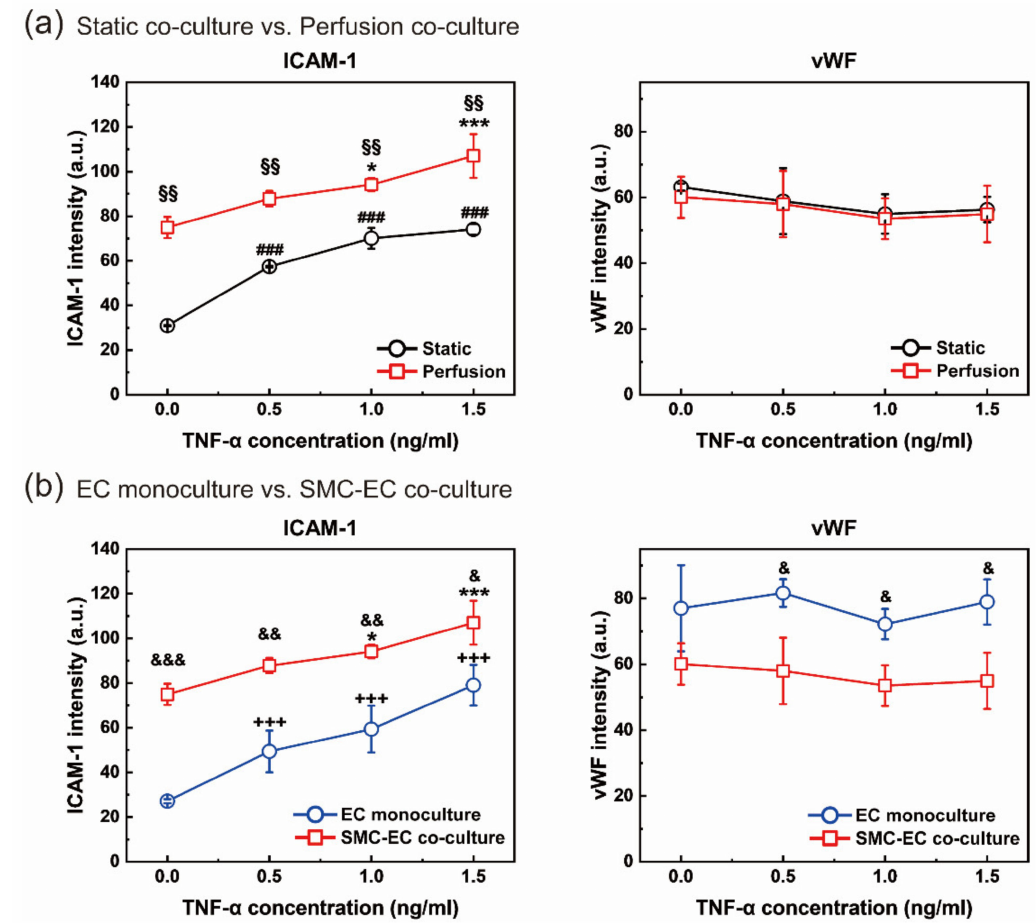
Figure 6. TNF- α dose-dependent ICAM-1 and von Willebrand factor (vWF) expression in the inflammation model. ( a ) Comparison of ICAM-1 and vWF expression between static and perfusion coculture conditions. For the ICAM-1 graph, §§ p < 0.01 vs. static culture conditions at the same TNF- α dose; * p < 0.05, *** p < 0.001 vs. no treatment channel in perfusion conditions; ### p < 0.001 vs. no treatment channel in static conditions. ( b ) Comparison of ICAM-1 and vWF expression between the EC monoculture and SMC–EC coculture models. & p < 0.05, && p < 0.01, &&& p < 0.001 vs. EC monoculture conditions at the same TNF- α dose. For the ICAM-1 graph, * p < 0.05, *** p < 0.001 vs. no treatment channel in SMC–EC coculture conditions; +++ p < 0.001 vs. no treatment channel in EC monoculture conditions. All n = 3 independent